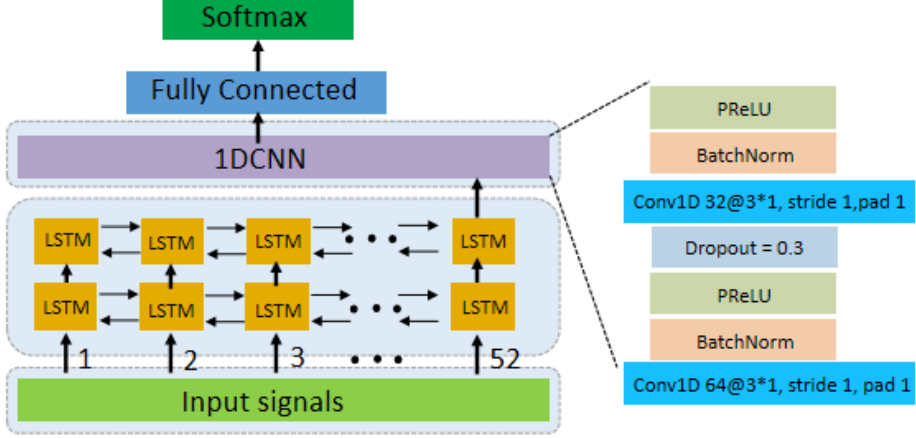
Figure 2. LCNN Architecture diagram, the LCNN consists of 2 LSTM layers, 2 one- dimensional convolution layers and 1 output layer. We use 2 LSTM layers, and each LSTM layer has 52 cells, and every cell has 64 hidden layers.